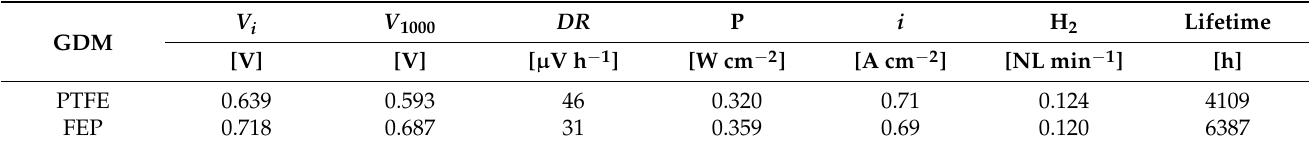
Table 1. Accelerated stress test (AST) experimental results for PTFE- and FEP-based single-lab-scale fuel cells. DR: degradation rate.